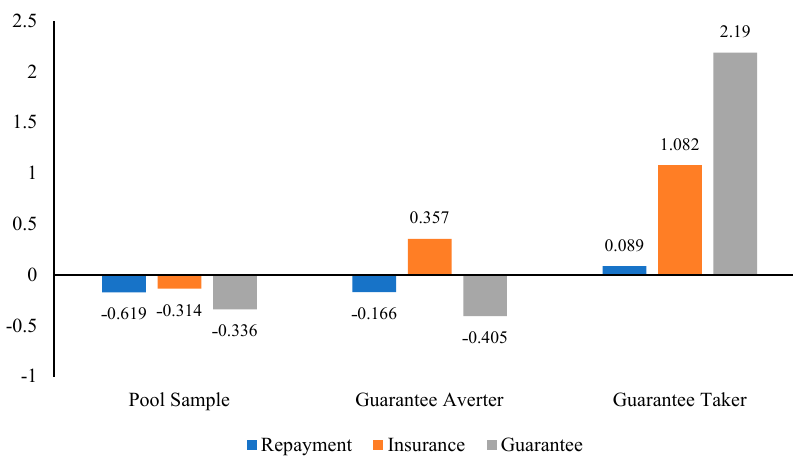
Figure 2. Farmers’ willingness-to-pay, mean [95% confidence interval].